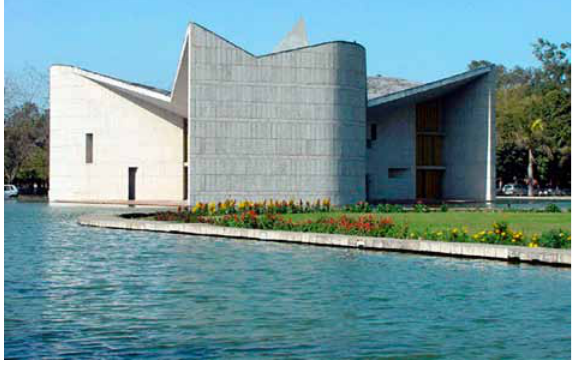
fig. 1. Gandhi Smarak Bhawan (Gandhi Bhawan